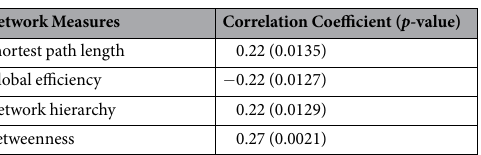
Table 4. Correlation between network properties and ACE-R total score. Network measures were estimated using a network-defining connectivity threshold value set to r = 0.2 (FDR q < 0.05, no adjustment for age and